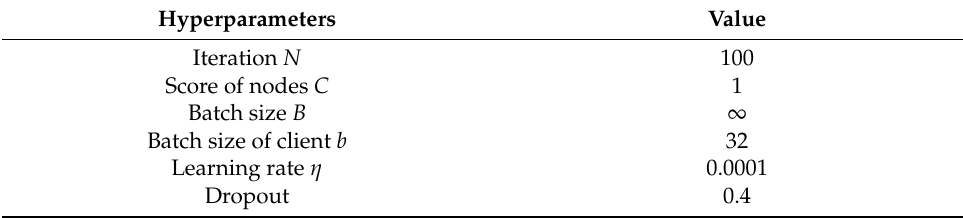
Table 2. Hyperparameters of Federated